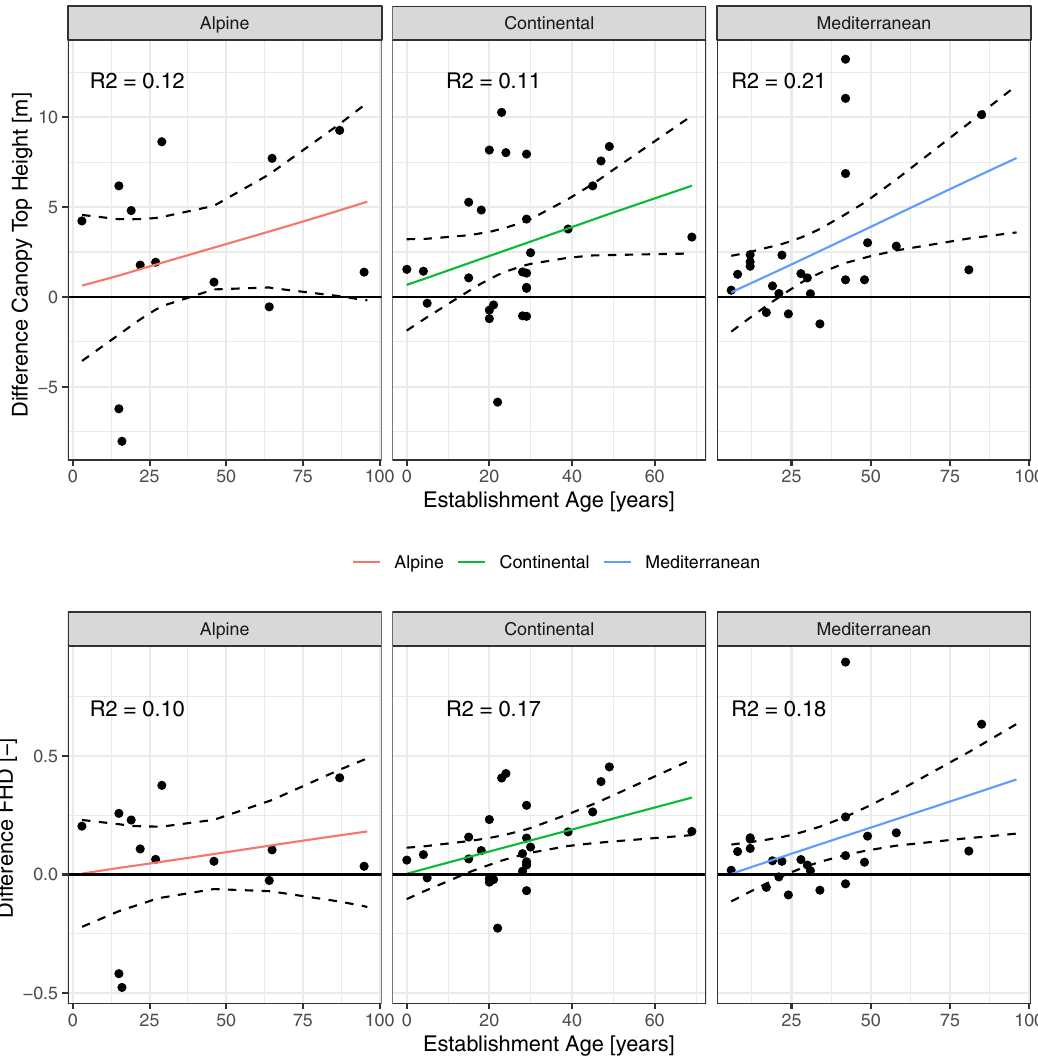
Fig. 5 Establishment age of PAs and differences in Canopy Top Height and Foliage Height Diversity between Protected Areas and Unprotected Surroundings. Relationship between Establishment age and difference in Canopy Top Height and Foliage Height Diversity between Protected Areas and Unprotected Surroundings based on biogeographical regions for the WDPA dataset. Dashed lines 95% show credibility intervals calculated from the posterior distributions of three linear models fi tted within a Bayesian